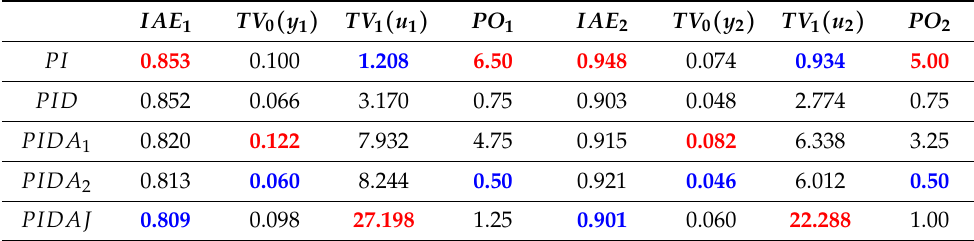
Table 1. Performance measures IAE , TV 0 ( y ) and TV 1 ( u ) corresponding to the setpoint steps from Figures 5 and 6 calculated for t 1 ∈ [ 5,15 ) , y ( t 1 ) = y 1 , u ( t 1 ) = u 1 , w ( t 1 ) = w 1 = 0.4, t 2 ∈ [ 65,75 ) ,